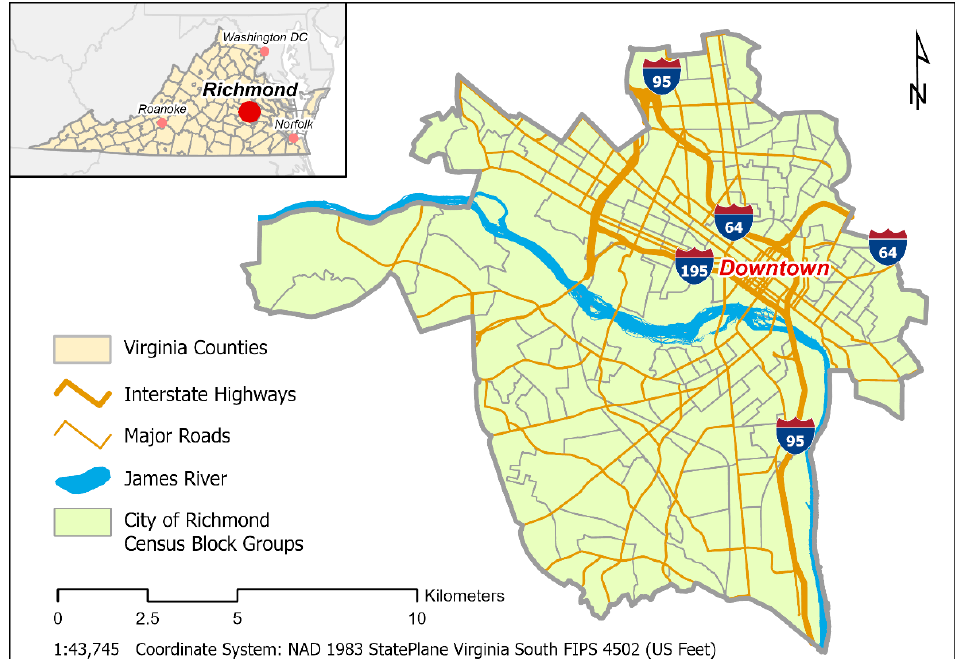
Figure 1. Study area and its location — the city of Richmond, Virginia.